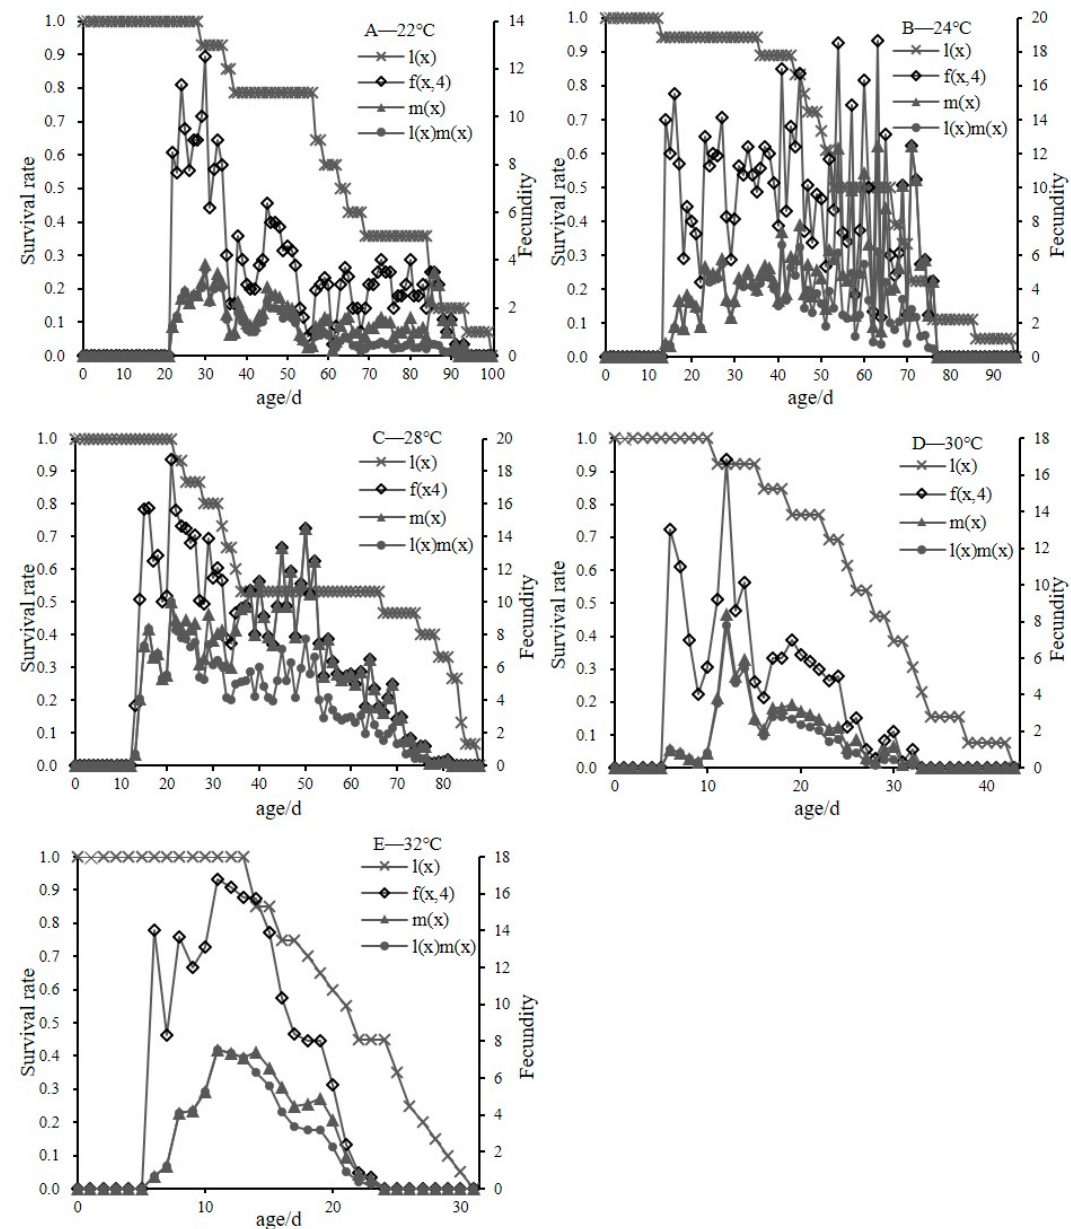
Figure 4. Age-specific survival rate ( l x ) fecundity ( m x ), maternity ( l x m x ), and age-stage specific fecundity ( f x 4 ) of C. malaccensis at di ff erent temperatures (A-E are 22, 24, 28, 30 and 32 ◦ C,